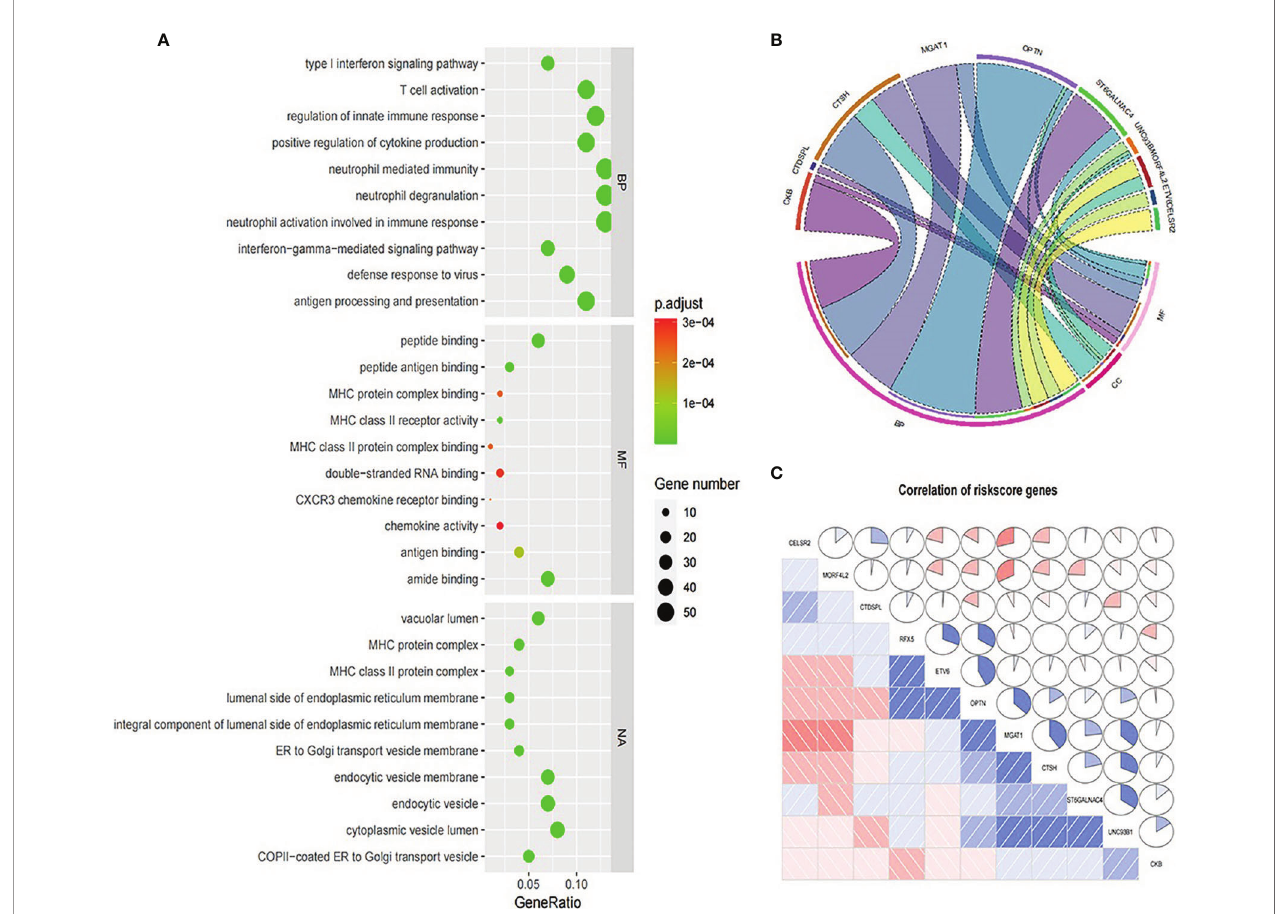
FIGURE 10 | Functional enrichment analysis. (A) GO analysis for 534 genes in MEbrown module. (B) GO analysis for 11 genes in the prognosis signature. (C) Expression correlation between 11 prognosis signature